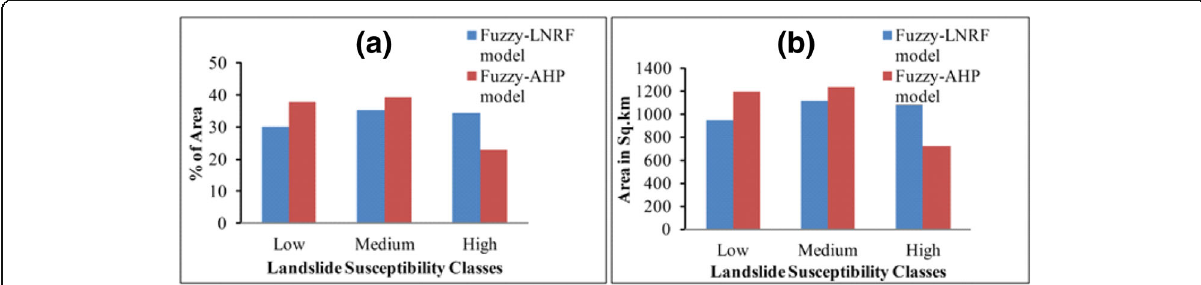
Fig. 7 Graph showing the distribution of area under different susceptibility classes a Percentage of area and b Area in